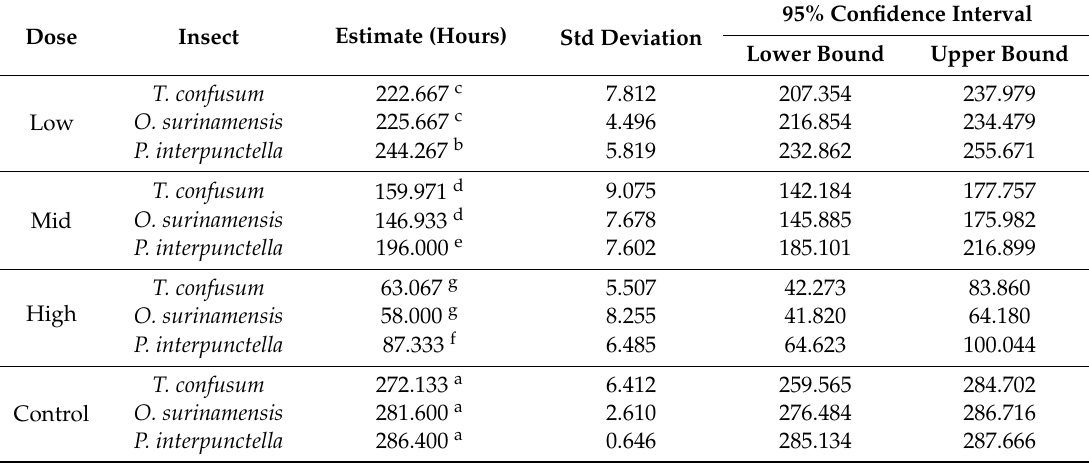
Table 2. Overall survival time of larvae in relation to dose and insect (Chi-square: 51.187, df = 1, p < 0.001). Means of the same column followed by the same letter are not significantly di ff erent (Long Rank test, p = 0.05).